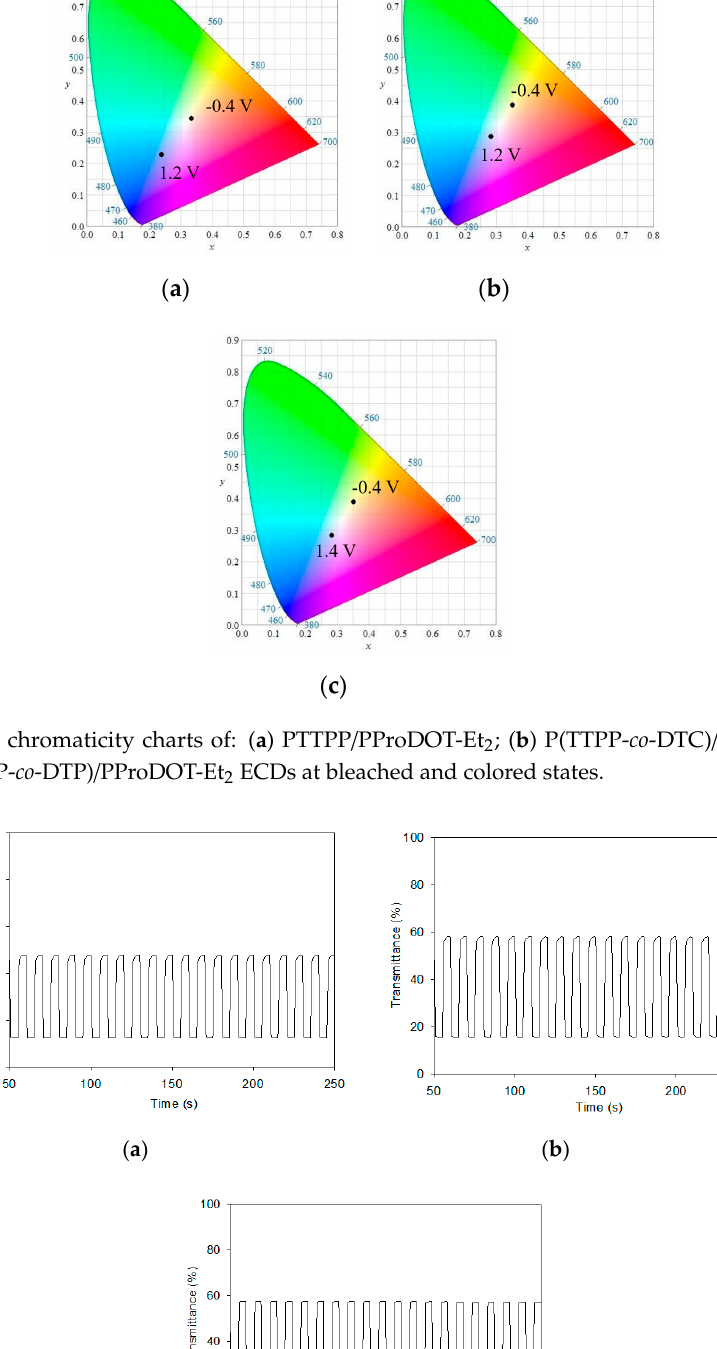
Figure 8. UV plots of: ( a ) PTTPP/PProDOT ‐ Et 2 ; ( b ) P(TTPP ‐ co ‐ DTC)/PProDOT ‐ Et 2 ; and ( c ) P(TTPP ‐ co ‐ DTP)/PProDOT ‐ Et 2 ECDs at various voltages.